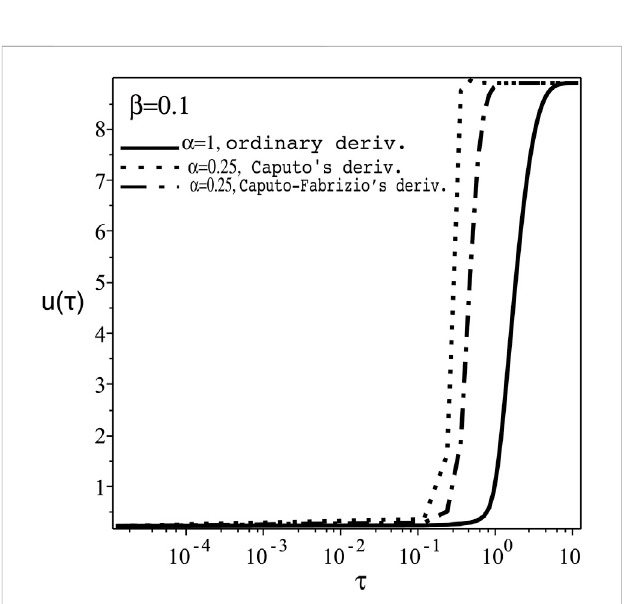
FIGURE 8 The transient Oxygen concentration, u ( τ ), versus the normalised time, τ with positive perturbation, κ = a c + β , a c =9.3643, at the switching-on point A on of Figure 7 with fi xed β =0.1 for α =1 (ordinary derivative) and 0.25 (Caputo ’ s and Caputo-Fabrizio ’ s fractional